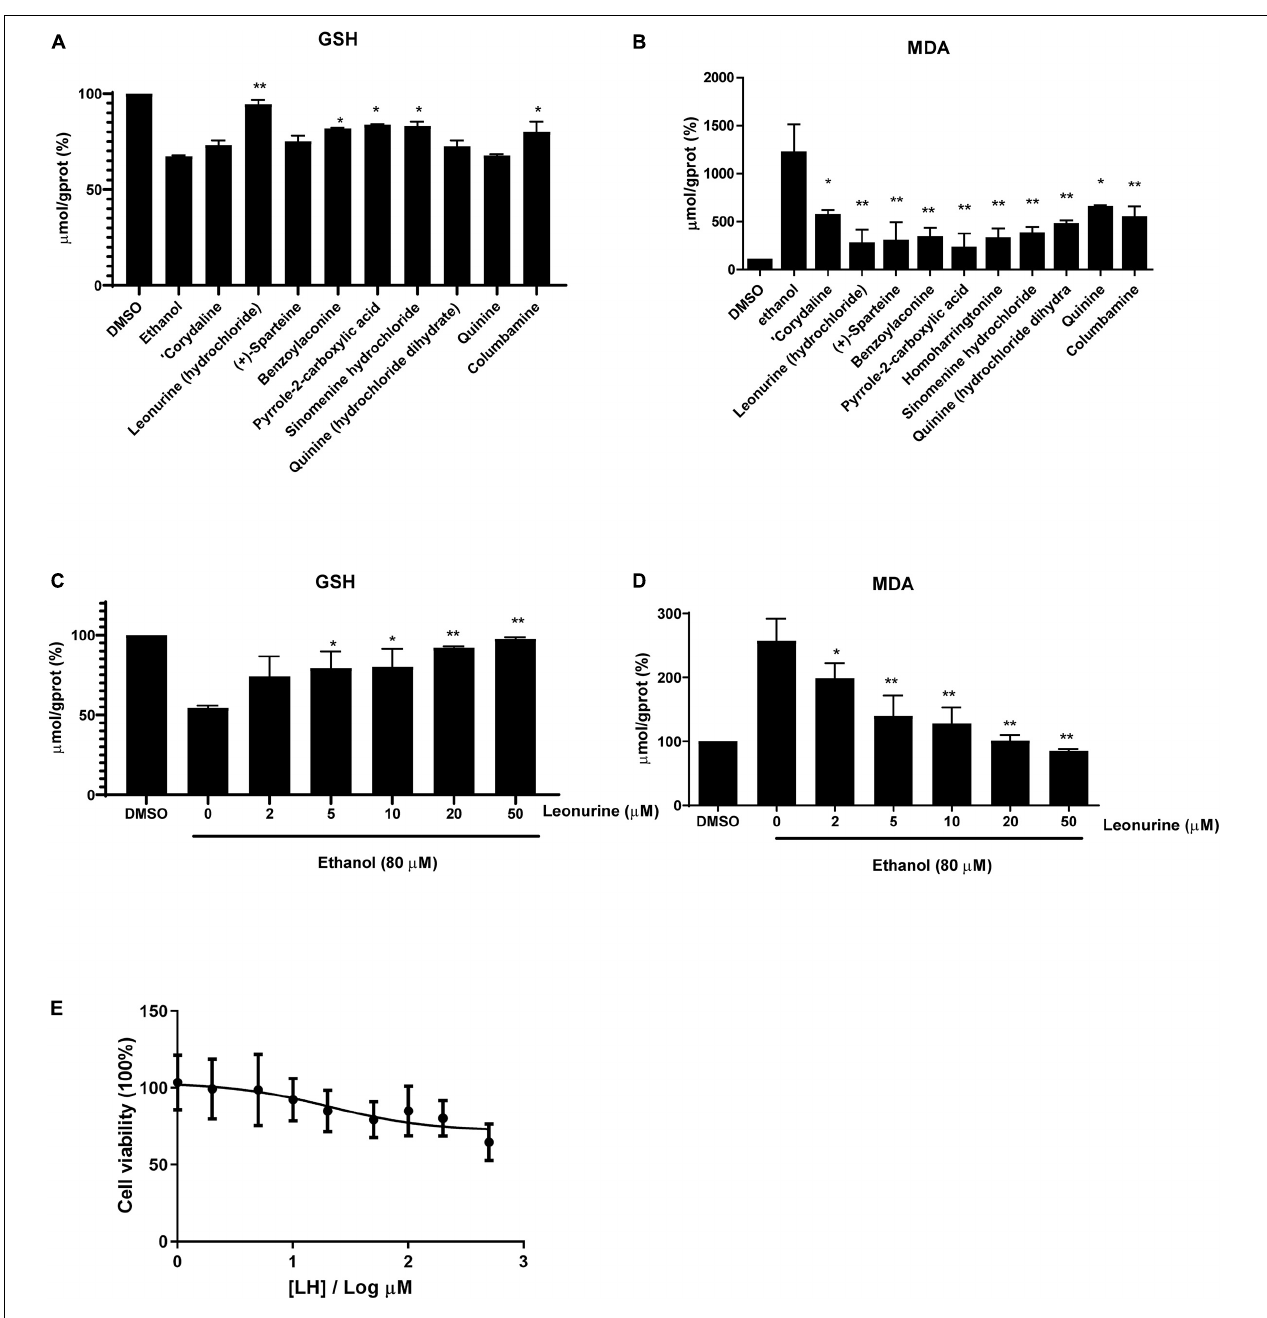
FIGURE 2 | The antioxidative activity of different alkaloids (10 µ M) against ethanol-treated LO2 cells. (A) The levels of Glutathione (GSH), (B) the levels of Malondialdehyde (MDA). (C) The levels of GSH in a dose-dependent manner (0–50 µ M). (D) The levels of MDA in a dose-dependent manner (0–50 µ M). The final result was normalized by protein concentration (mg prot/mL) and the unit of the final result was µ mol/g prot. Values are expressed as mean ± SEM ( n = 3). * and ** indicated a significant difference at p < 0.05 level, a highly significant difference at p < 0.01 level, respectively, between ET group vs. different alkaloid groups using the independent t -test. (E) Cell viability of LO2 cells after exposure to Leonurine hydrochloride (LH) (0–500 µ M) for 24 h. Values are expressed as mean ± SEM ( n = 6).